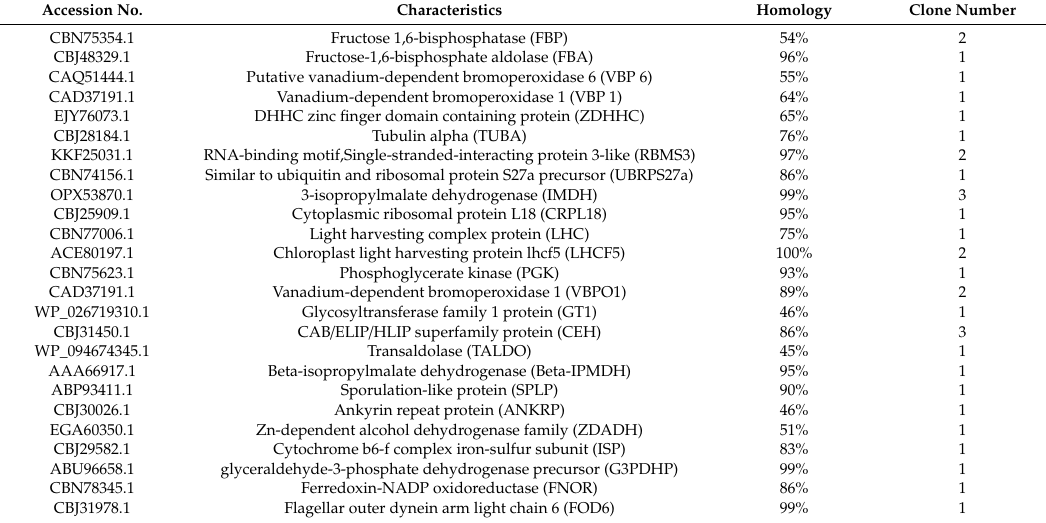
Table 2. BLAST analysis of yeast two-hybrid results using SjAUREO as bait to screen the DK treated cDNA library. Accession